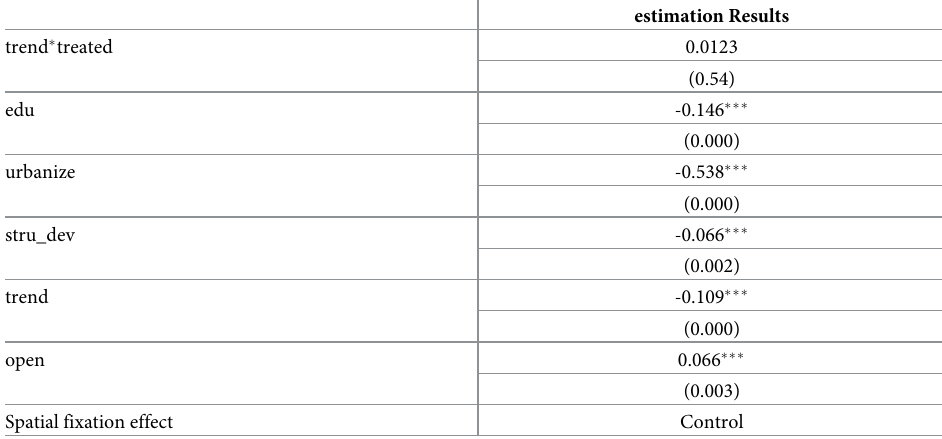
Table 4. Parallel trend